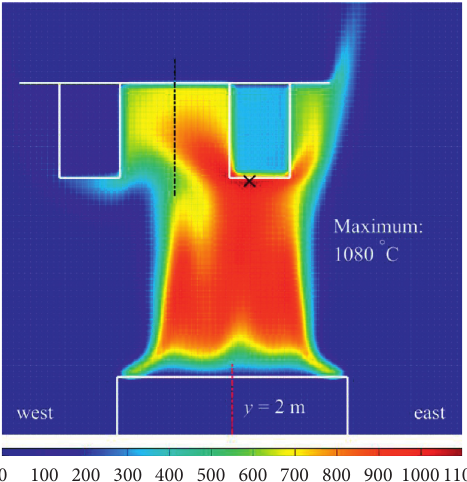
Figure 6: Gas temperature (sectional view).